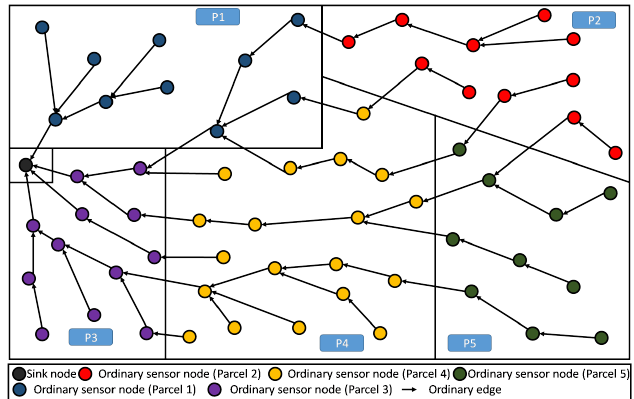
Figure 3. DODAG resulting from standard RPL deployed in a sample